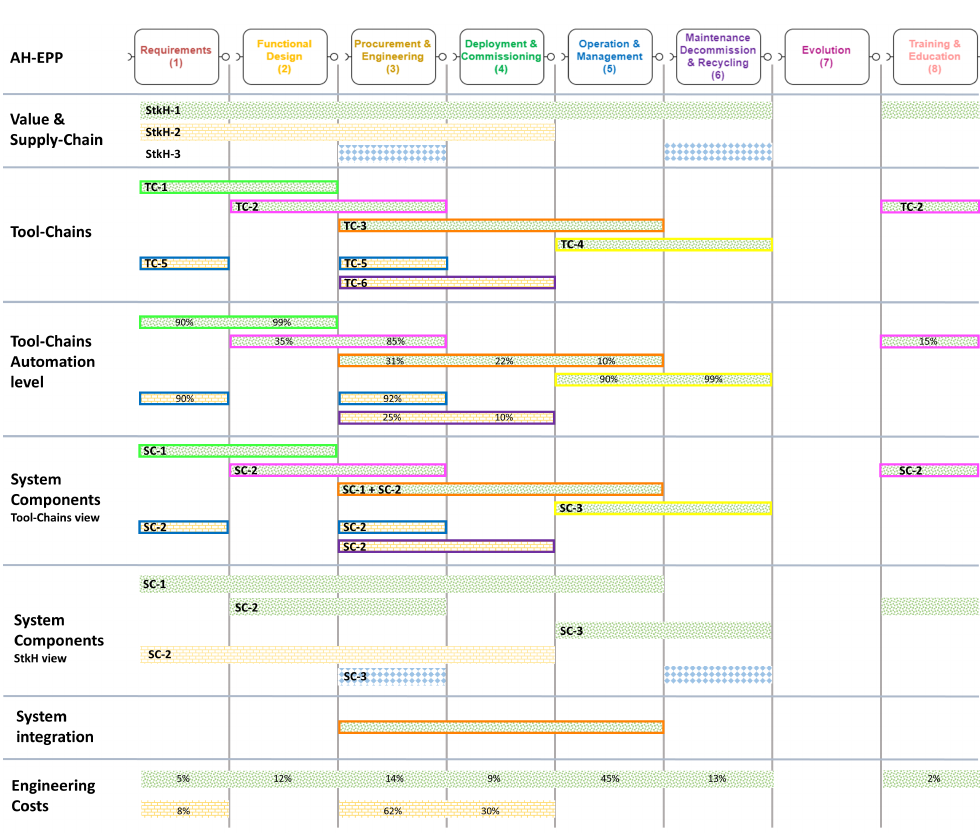
Figure 6. Example of a VCEP map showing value chain information at glances designed to express supplementary information of the use case defined with the Arrowhead-EP (AH-EP)